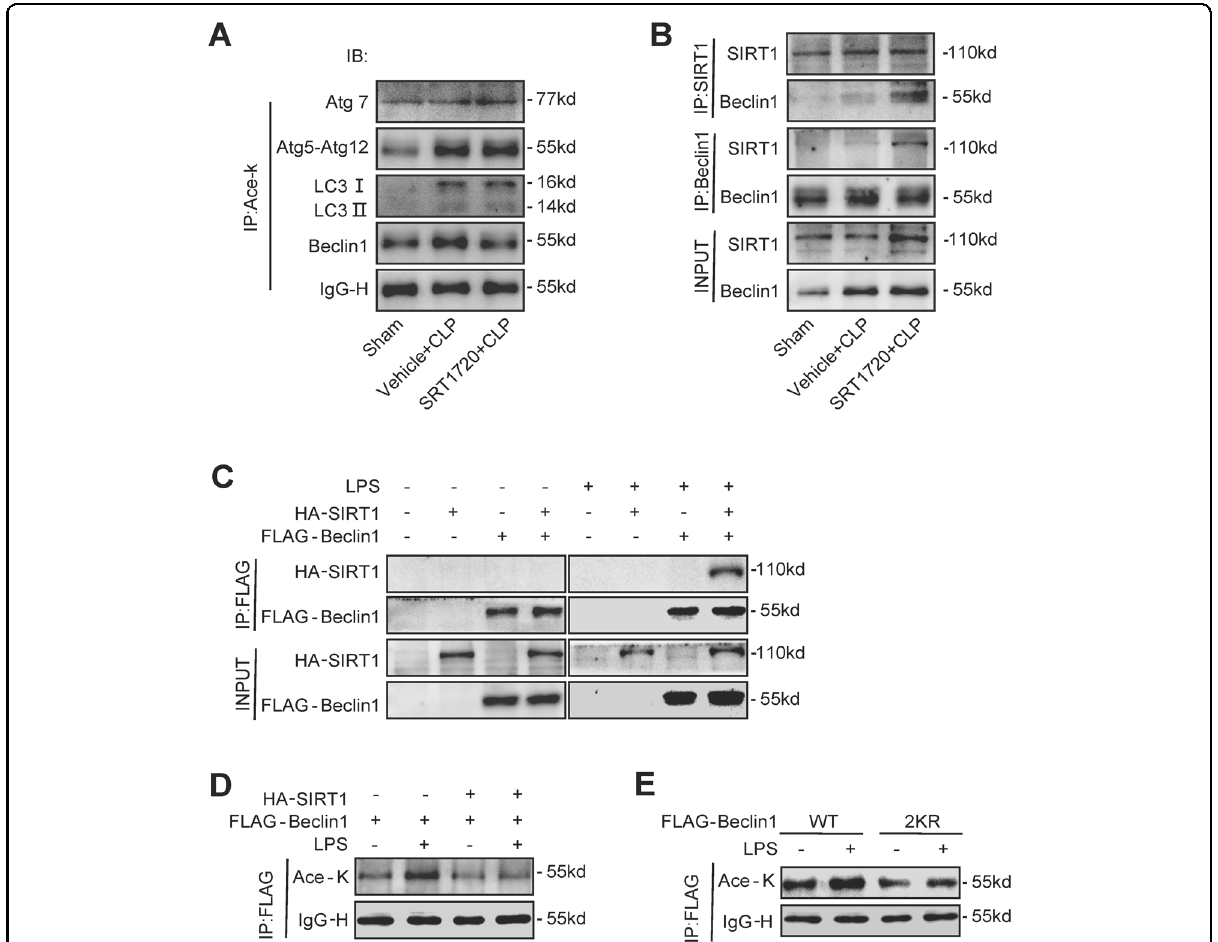
Fig. 5 SIRT1 activation promotes the deacetylation of Beclin1 but not the other autophagy-related proteins. The mice were euthanized 12 h after CLP-induced SAKI. A The acetylation levels of Atg5 – Atg12, Atg7, LC3 and Beclin1 and representative western blots are shown. The kidney samples were immunoprecipitated with anti-acetyl-lysine antibodies to analyse the acetylation of Atg5 – Atg12, Atg7, LC3 and Beclin1. B Association of Beclin1 with SIRT1 in the SAKI animal model. The interaction between Beclin1 and SIRT1 was determined by Co-IP. C Association of Beclin1 with SIRT1 in the SAKI cell model. HA-tagged SIRT1 and FLAG-tagged Beclin1 were individually transfected into HK-2 cells with or without LPS stimulation. The interaction between Beclin1 and SIRT1 was determined by Co-IP. D The acetylation of Beclin1 after SIRT1 overexpression was examined by immunoprecipitation and western blotting. E The acetylation of Beclin1 markedly decreased after double mutation of K430 and K437. FLAG-tagged Beclin1 (WT, 2KR) was transfected into HK-2 cells with or without LPS stimulation. The acetylation of Beclin1 was examined in immunoprecipitation assays and representative western blots are shown. SAKI sepsis-induced acute kidney injury, LPS lipopolysaccharide, Co-IP Co-immunoprecipitation, SIRT1 silent mating-type information regulation 2